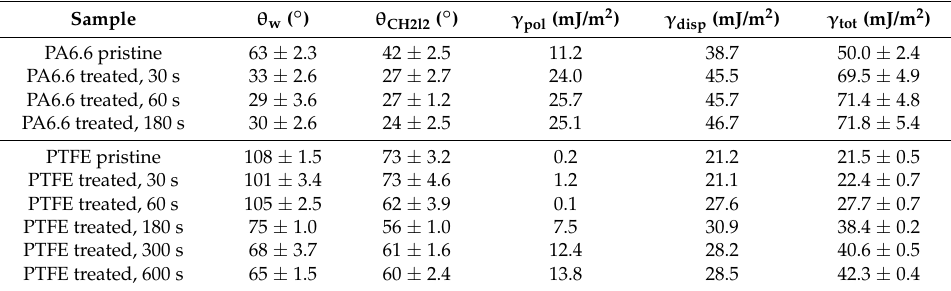
Table 2. Contact angle and surface energy values of the pristine and the plasma treated polymer samples measured at various times after